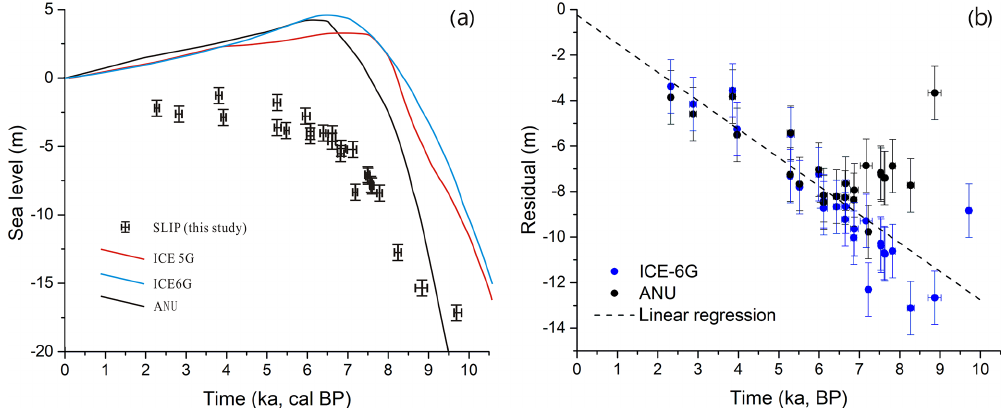
Figure 7. Observed and predicted sea level in Bohai Bay and resulting residuals: (a) SLIPs generated in this study and sea-level predictions. ICE-5G, ICE-6G and ANU are GIA models described in Sect. 3.6. Lithospheric thickness (km): 65 (ANU), 90 (5G and 6G); upper mantle viscosity (Pas): 0 . 5 × 10 21 (ANU, 5G, 6G); lower mantle viscosity (Pas): 10 × 10 21 (ANU), 2 . 7 × 10 21 (5G), 3 . 2 × 10 21 (6G); see also Table S1; age error bars are too small to be clearly visible. (b) Sea-level residuals plotted against time. Residuals are the difference between SLIPs and interpolated model data points. Error bars are derived from SLIP uncertainties. The trend line (dashed line) is computed as a least-squares regression on the mean residuals obtained with ANU and ICE-6G. The regression line approximates zero elevation remarkably closely, which gives confidence that the calculated 1.25mma − 1 for the non-GIA component is